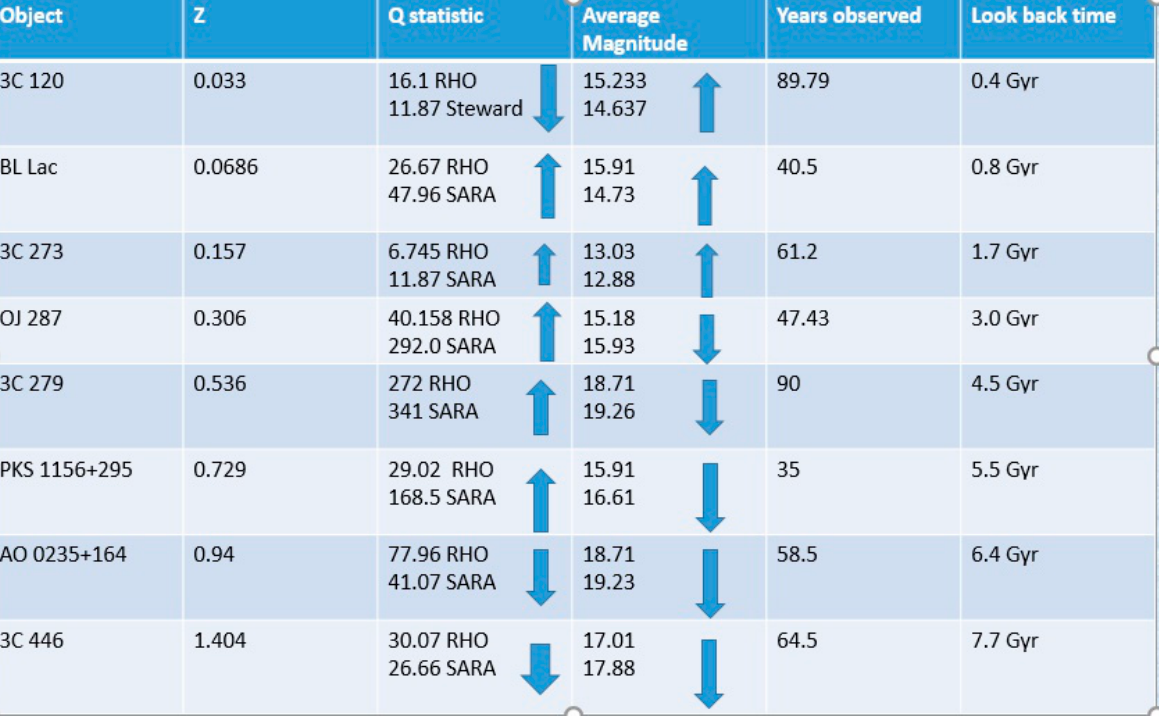
Figure 2. The long-term variability behavior of 8 Blazars over nearly 100 years of monitoring observations.